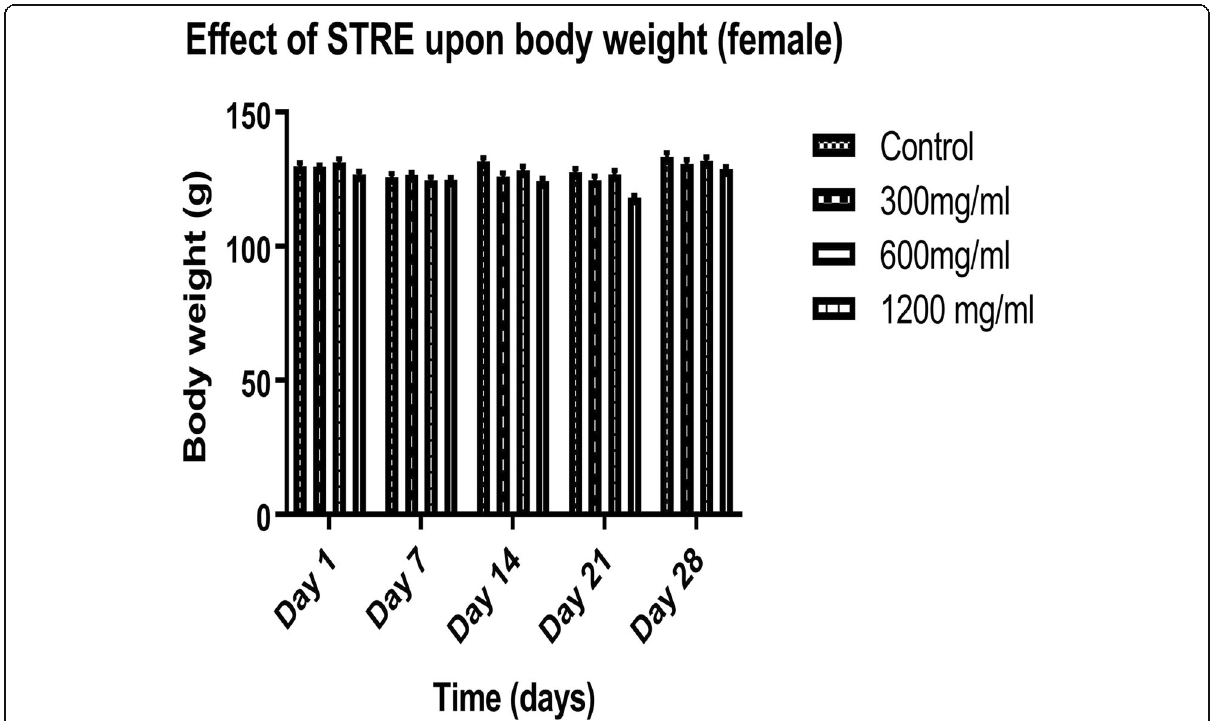
Fig. 2 Effect of STRE on bodyweight of female subjects. Values are expressed as mean ± SEM Statistical significance (p) calculated by one way ANOVA followed by dunnett ’ s ( n = 6)